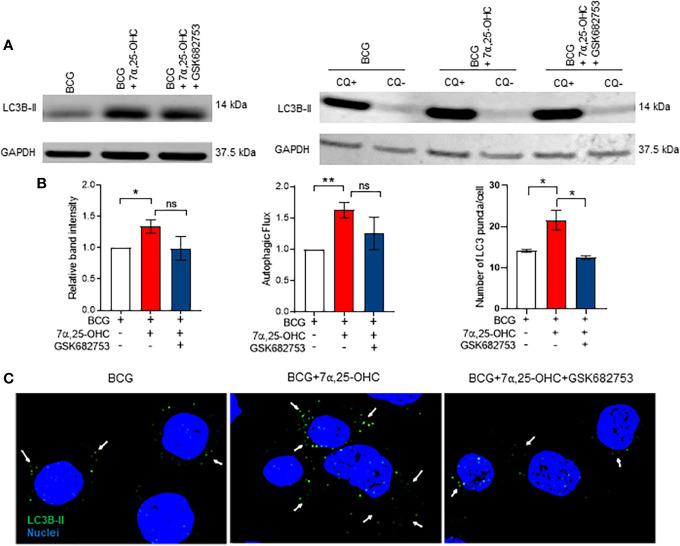
Treatment with 7α,25-OHC induces autophagy. PMA-differentiated THP-1 cells were infected/uninfected and co-incubated with ±7α,25-OHC, ±GSK682753, for 2 h. Extracellular BCG was removed, and cells were incubated for a further 4 h or 22 h in RPMI medium containing drugs. (A) Cells were lysed at 6 h or 24 h (Flux) p.i. (B) The band intensity was then normalized to the reference protein, GAPDH and further normalized to the BCG. Autophagic flux was obtained by subtracting chloroquine positive values with chloroquine negative values. (C) Cells were visualized using the Olympus FV 3000 confocal microscope. At least 30 cells were counted for every condition. Data are presented as ± SEM; ns, P > 0.05; *P ≤ 0.05; **P ≤ 0.01; unpaired t-test.